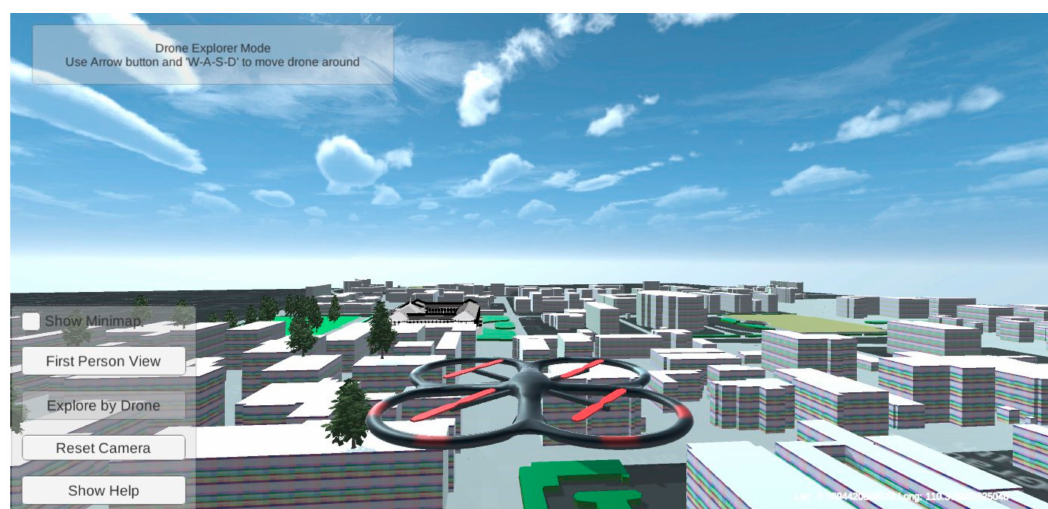
Figure A3. Screenshot of Bird Eye View navigation.